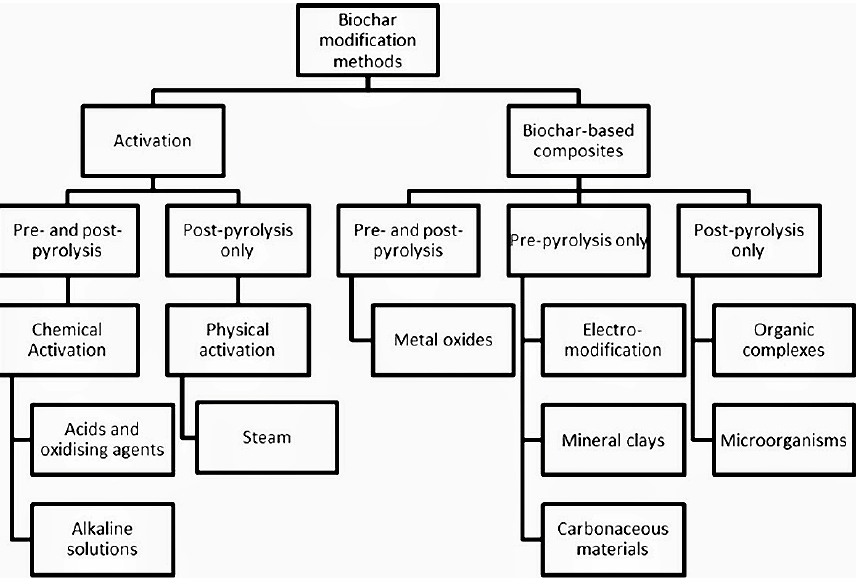
Figure 2. A grouping framework of biochar modification methods [82]. Reprinted with permission from Tom Sizmur et al. (2017). Copyright 2017, Elsevier.